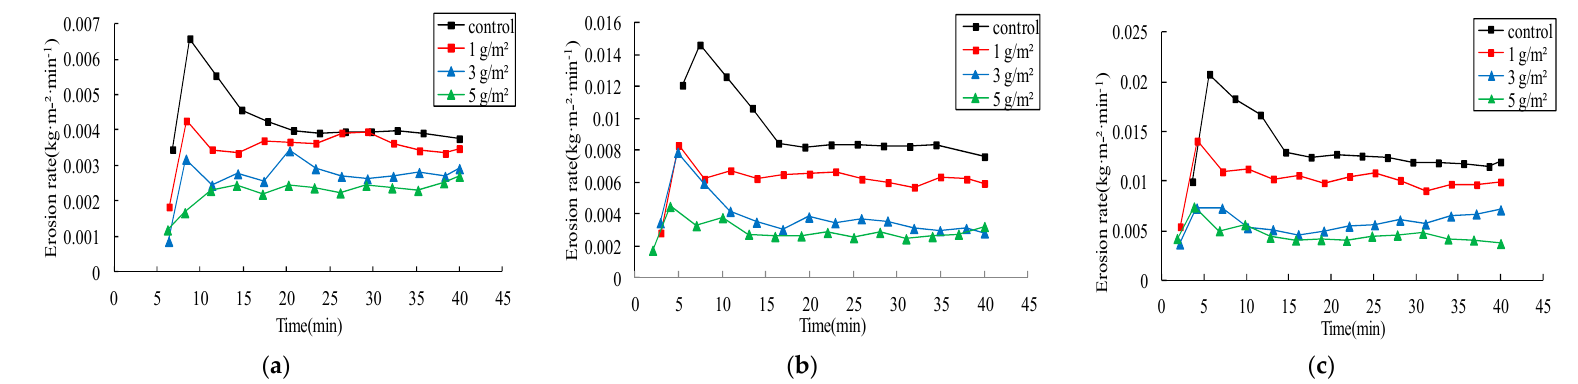
Figure 5. Erosion rates of spraying Jag S under three rainfall intensities. ( a ) 1.0 mm/min; ( b ) 1.5 mm/min; ( c ) 2.0 mm/min.